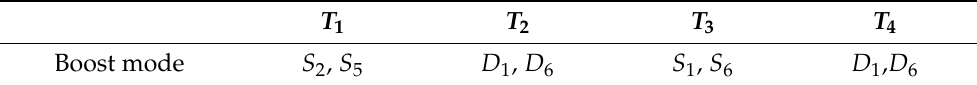
Table 2. Conduction of switches in different time intervals in FC2DC